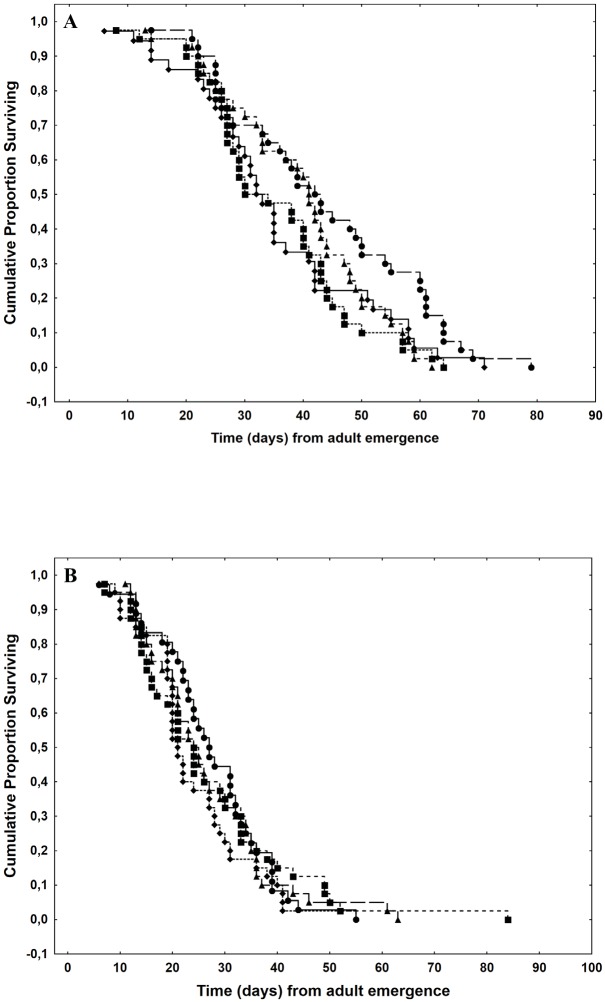
Survival curves for adult Diachasmimorpha longicaudata reared on Ceratitis capitata larvae that developed in different host fruit.Different fruit species are labelled with a different shape: Apple: circles; Fig: squares; Orange: triangles; Peach: diamonds. (a) males and (b) females.